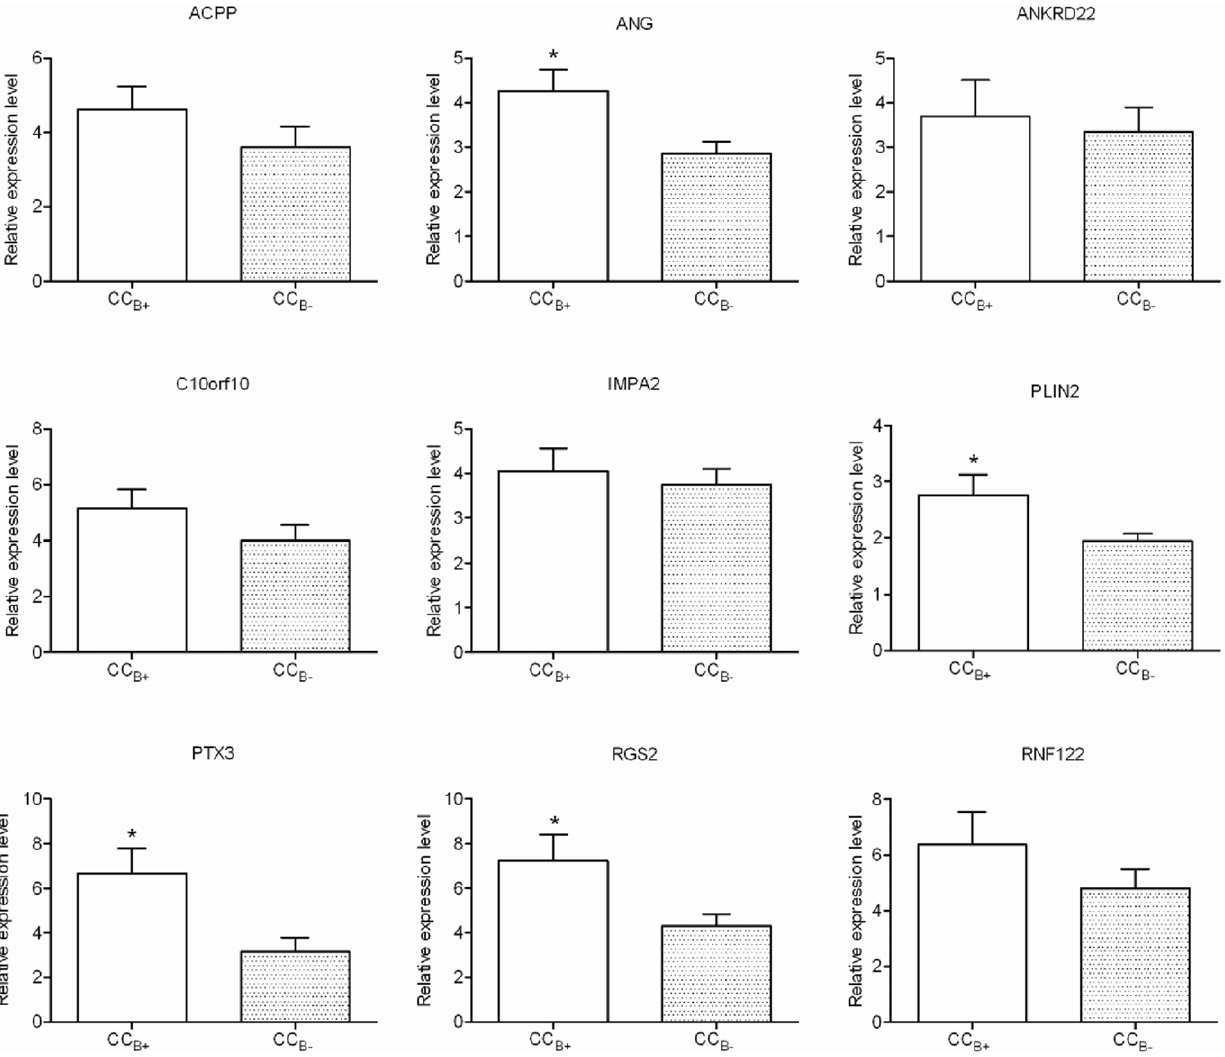
Figure 5. Relative expression level obtained by qPCR of 9 genes differentially expressed according to oocyte developmental competence. Results were expressed as means 6 SEM of relative expression to the reference gene RPL19. CC B + , cumulus cells from mature oocyte yielding a blastocyst at day 5/6 of in vitro culture once fertilised; CC B-, cumulus cells from mature oocyte which stopped developing at the embryo stage at day 5/6 of in vitro culture once fertilised; *, significant difference (p , 0.05).